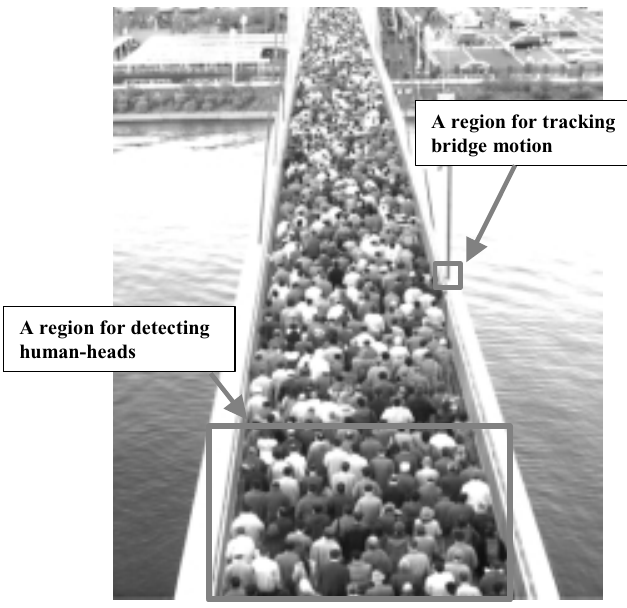
Fig. 3. An example of sequential images recorded in T-Park Bridge and two regions for image